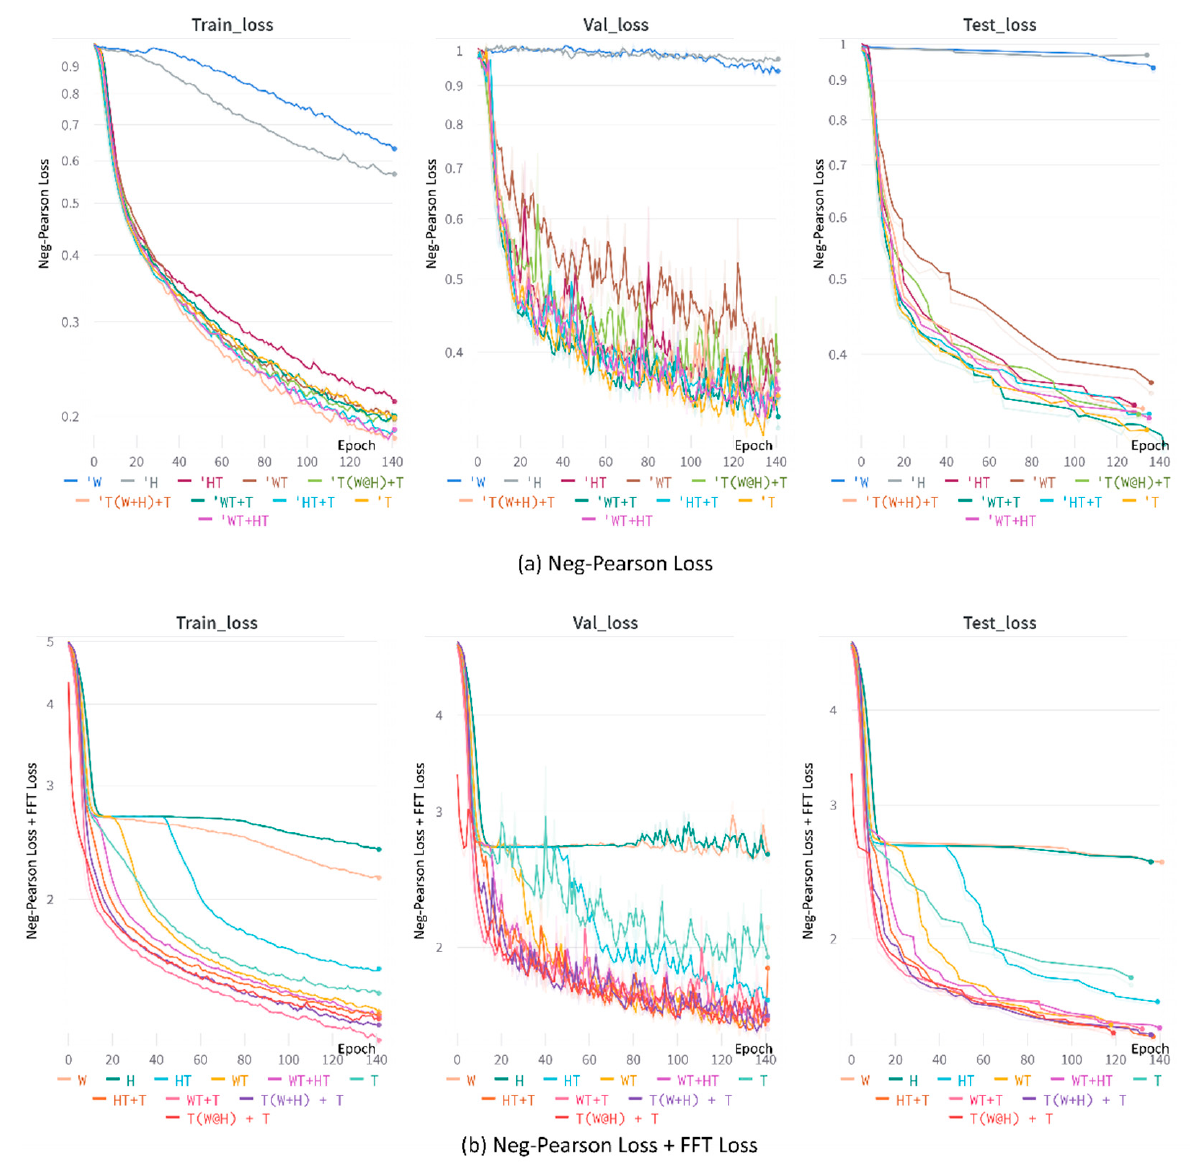
Figure 5. Loss graphs of APNET. ( a ) Neg-Pearson Loss; ( b ) Neg-Pearson loss + FFT Loss.